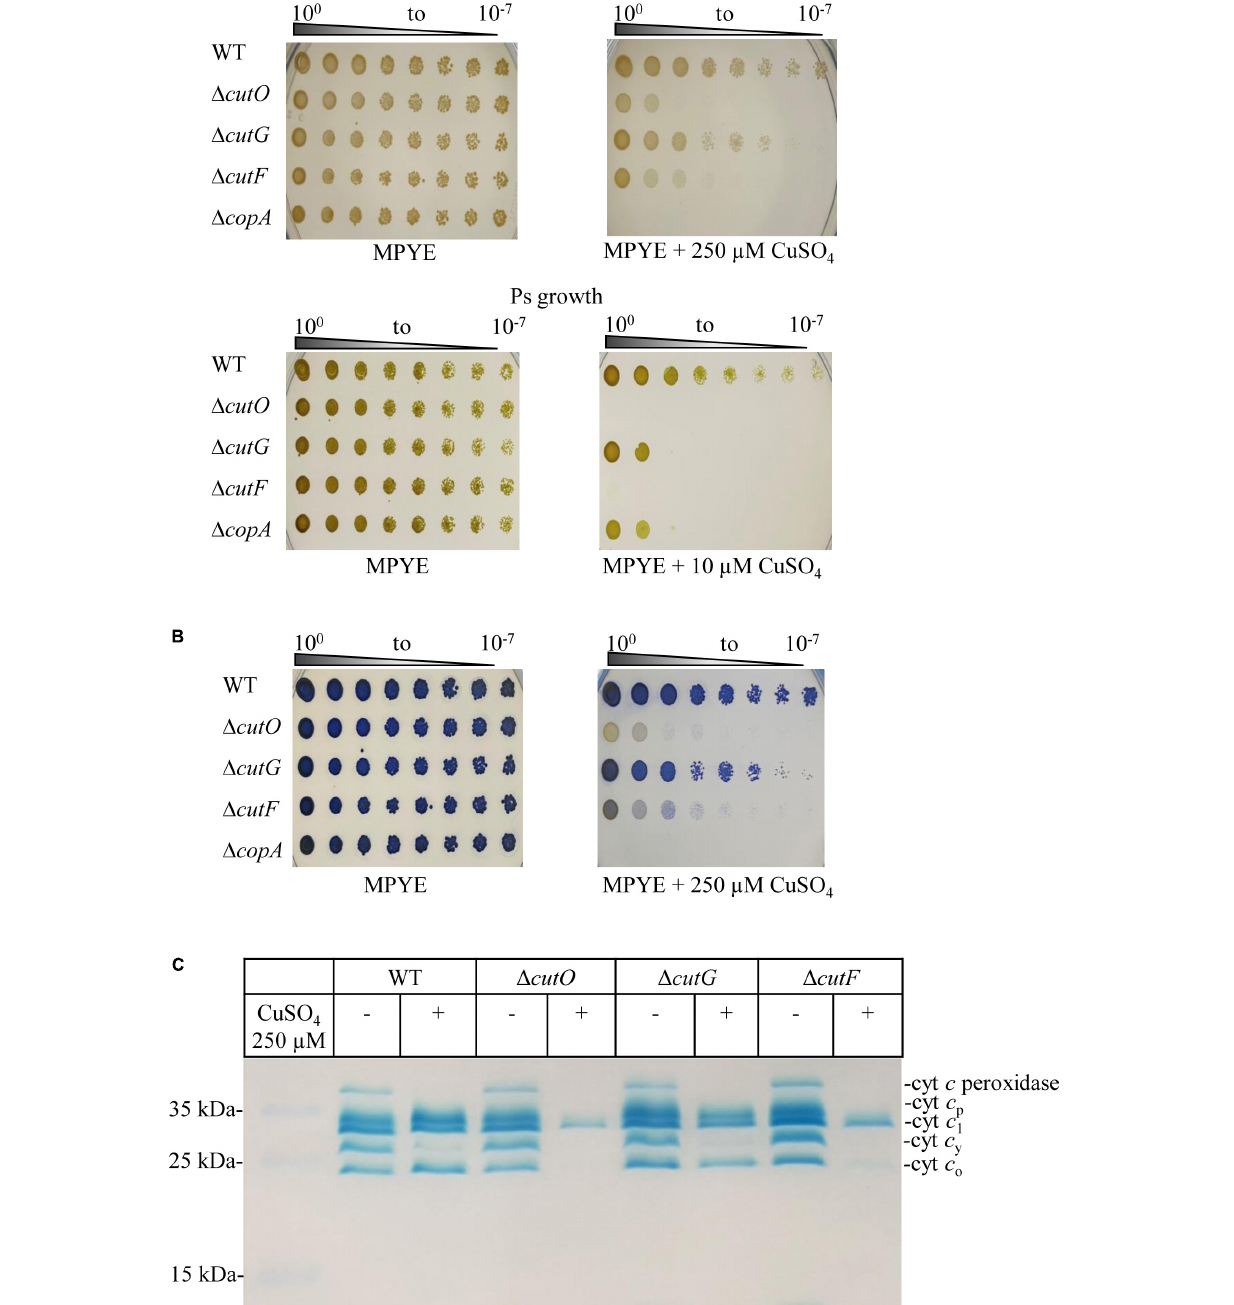
Frontiers in Microbiology |